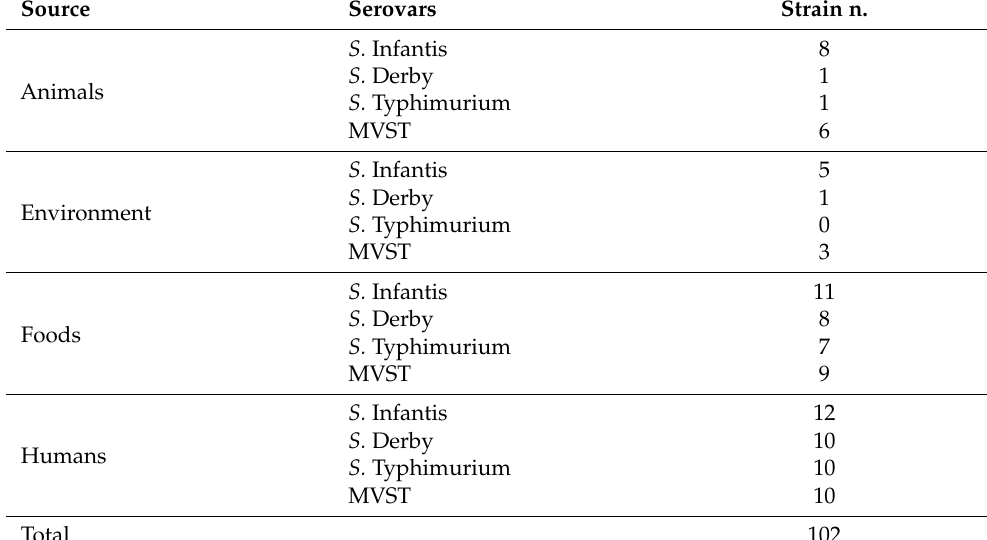
Table 1. Source and serotypes of Salmonella